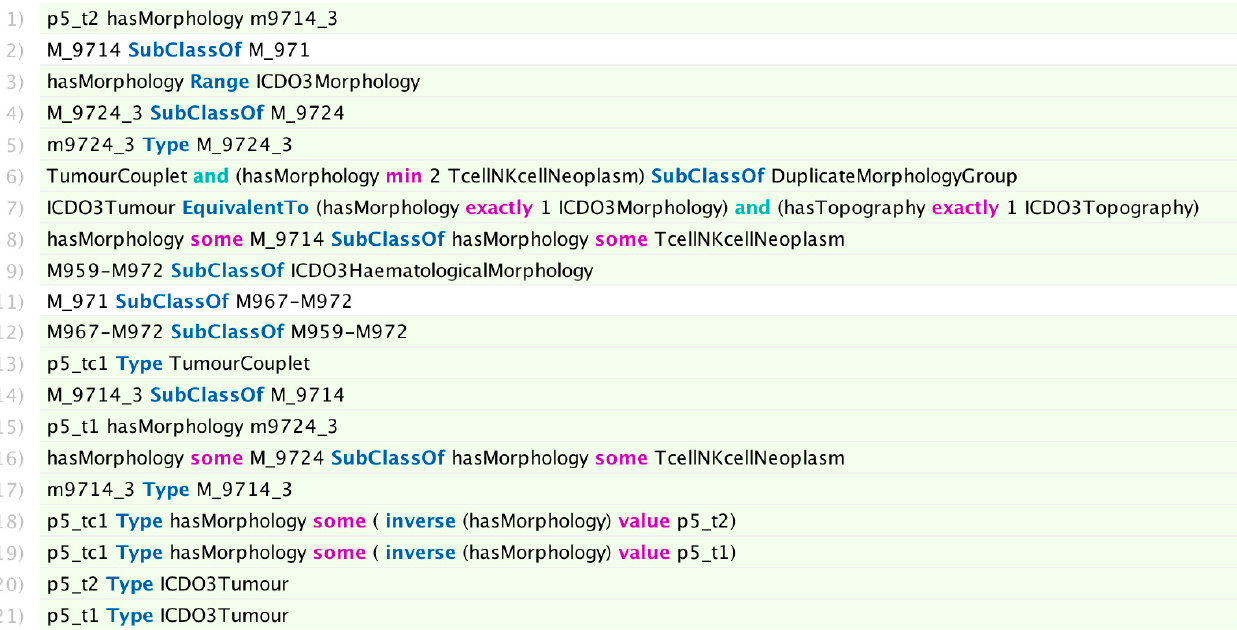
Figure 14. Explanation provided by the reasoner for the result of the DL query in Figure 13. Lines 8 and 16 reveal that the two morphologies in the couplet belong to the TcellNKcellNeoplasm category and therefore trigger the duplicate morphology group condition (line 6). Line 9 reveals that both morphologies are classified as haematogical morphologies. This set of conditions serves to flag the duplicate primary tumour condition of p5_tc1 in the related Figure 10, c.f. Axiom (3).